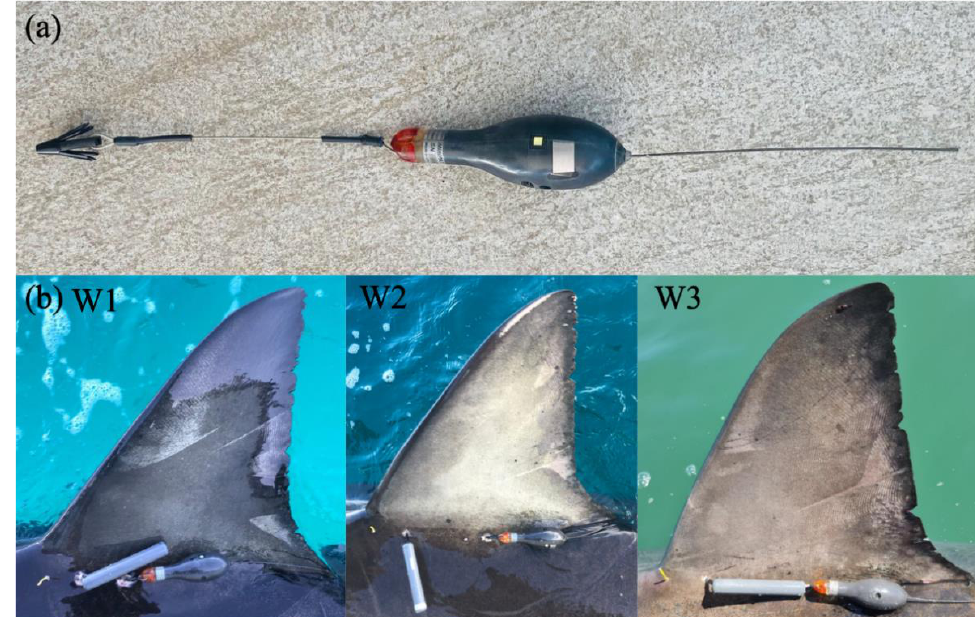
Figure 2. ( a ) MiniPAT-348 Pop-up Satellite Archival Transmitting Tag and Domeier dart head used to anchor the MiniPAT tags and acoustic transmitters into the sharks musculature, and ( b ) dorsal fins of the three white sharks used in the present study. Images taken after completing tagging procedure, with MiniPAT tags, acoustic transmitters and conventional tags visible (images provided by the New South Wales Department of Primary Industries).